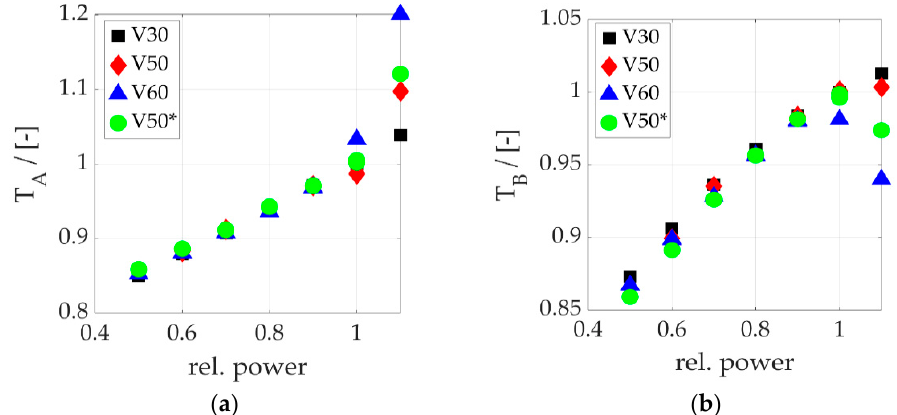
Figure 16. Normalized average temperature of four circumferentially distributed thermocouples with respect to the relative engine power; measured for four fluidic nozzle variants with different spray opening angles (V30, V50, and V60) and flow numbers (V50 and V50*), respectively. Thermocouples located ( a ) at the mixing tube exit (flame tube inlet) and ( b ) at an axial position further downstream at two-thirds of the flame tube